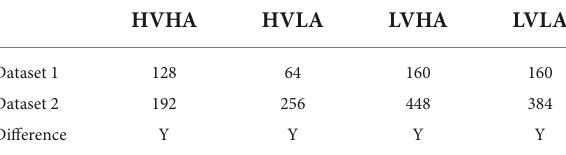
TABLE 1 Sample distribution.